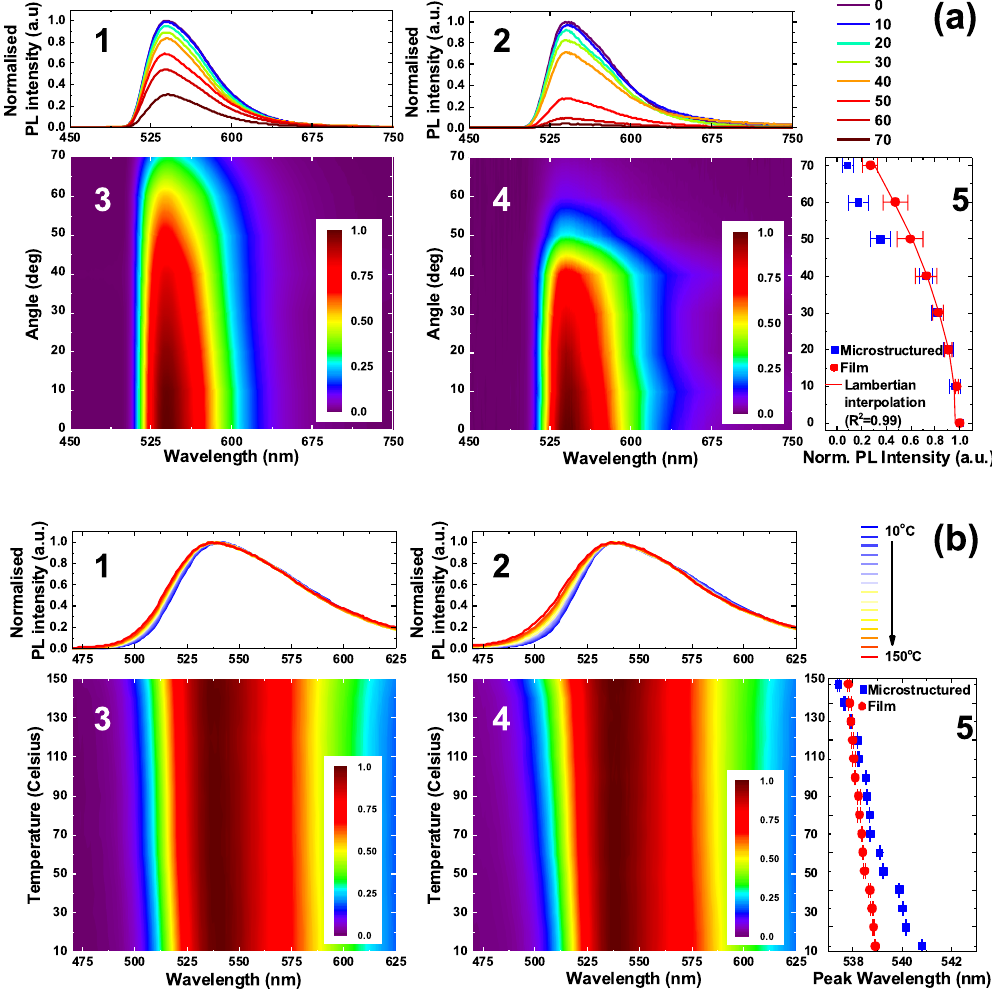
Figure 3. Optical Characterization of Micrometric Suspended F8BT Membrane Lattices. ( a ) PL emission as a function of the collection angle: normalized PL spectra as a function of the collection angle (a-1, a-2) and the relative contour plots (a-3, a-4) referring to F8BT suspended membrane lattices featuring pitch of 3 μ m obtained drop-casting 10 μ L of 1 wt% polymer solution (a-2, a-4) and F8BT films (a-1, a-3), together with a graph comparing spectrally integrated PL versus collection angle for both sets of samples (a-5). ( b ) PL emission as a function of the temperature: normalized PL spectra as a function of the temperature (b-1, b-2) and the relative contour plots (b-3, b-4) referring to F8BT suspended membrane lattices featuring pitch of 3 μ m obtained drop- casting 10 μ L of 1 wt% polymer solution (b-2, b-4) and F8BT films (b-1, b-3), together with a graph comparing the emission peak wavelength versus the operation temperature for both sets of samples